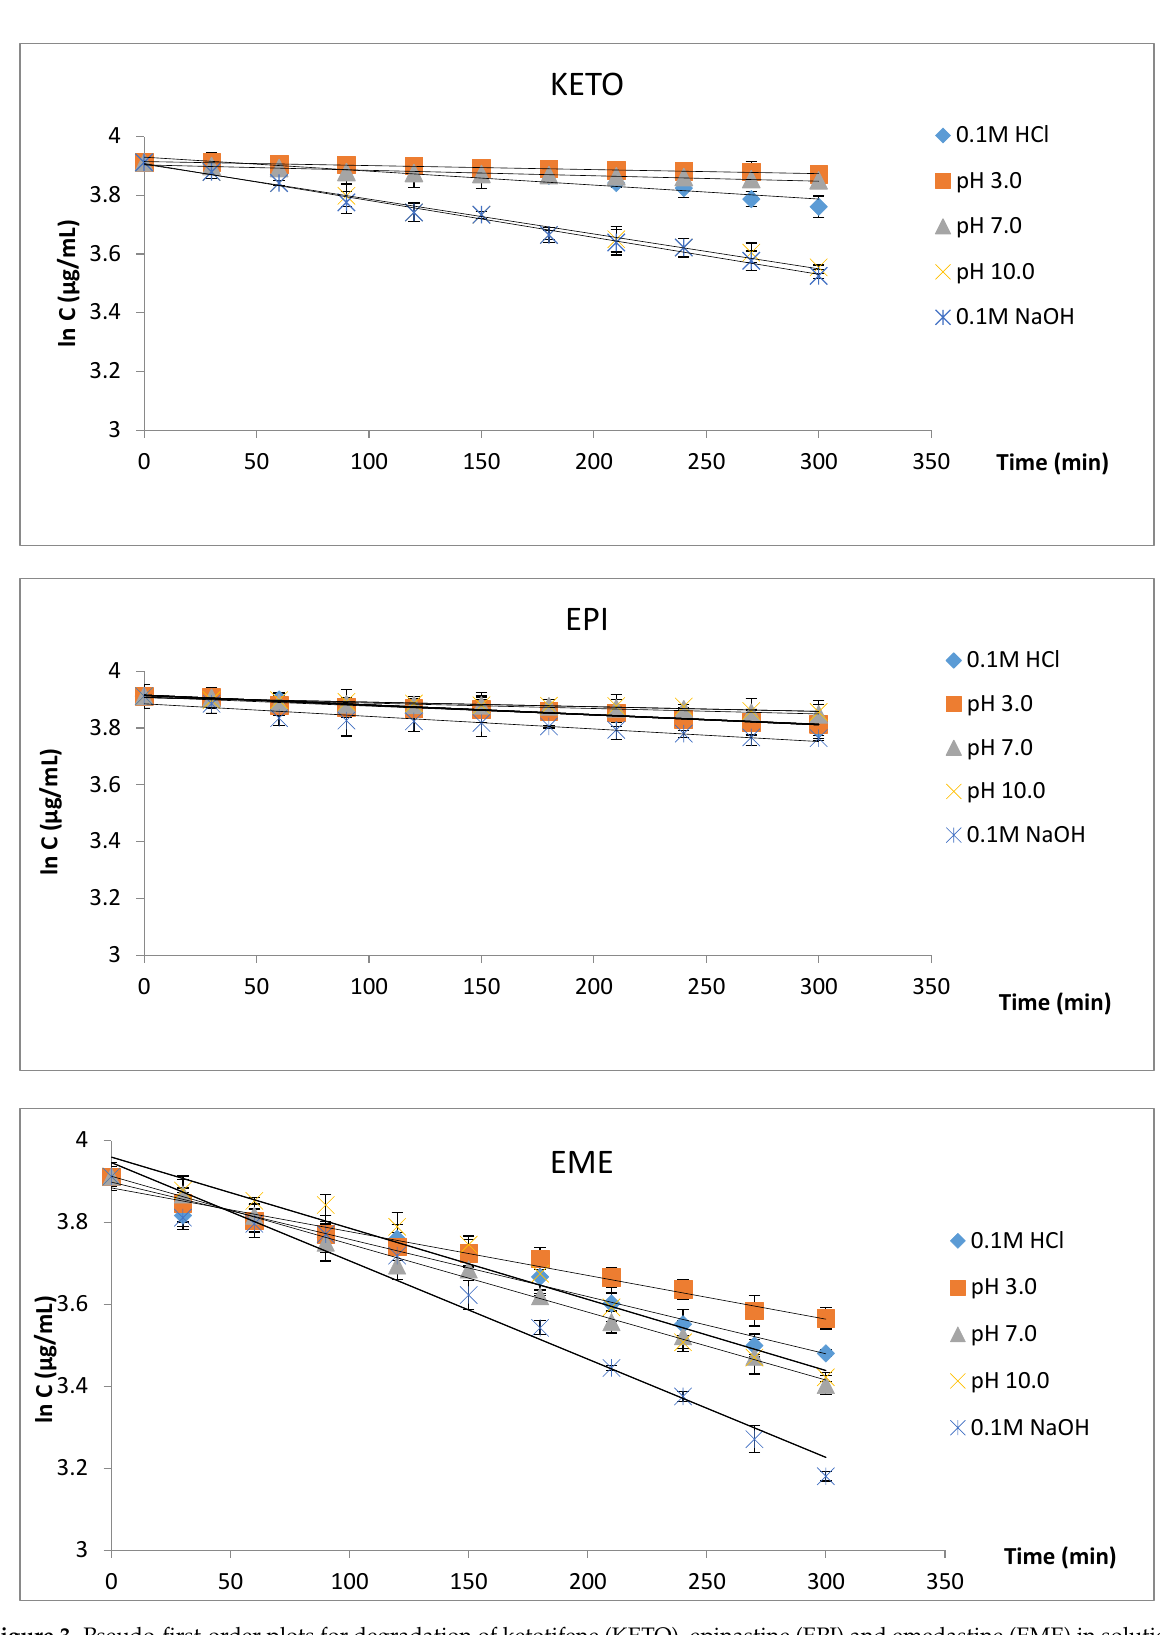
Figure 3. Pseudo-first-order plots for degradation of ketotifene (KETO), epinastine (EPI) and emedastine (EME) in solutions of different pH at 70 ◦